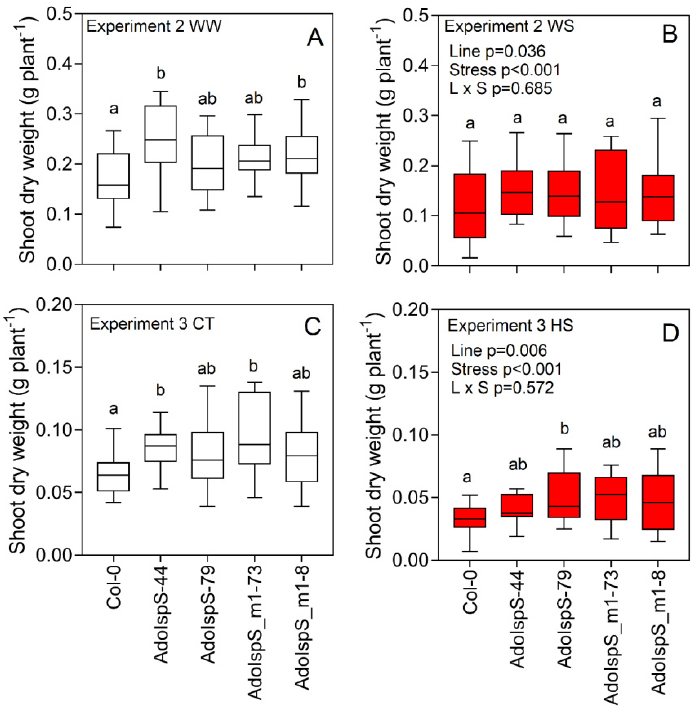
Figure 3. Shoot dry weight for Col-0, isoprene emitters (AdoIspS-44 and AdoIspS-79), and ocimene emitters (AdoIspS_m1-73 and AdoIspS_m1-8) Arabidopsis lines grown under control and stress conditions. In Experiment 2 (A and B), plants were grown under control (A) and water stress conditions (B) while in Experiment 3 (C and D), plants were grown under control (C, 23 °C temperature) and heat stress conditions (D, 29 °C temperature) (n = 12). The two-way ANOVA output is shown in the graph. Different letters represent significant differences according to Fisher’s test.